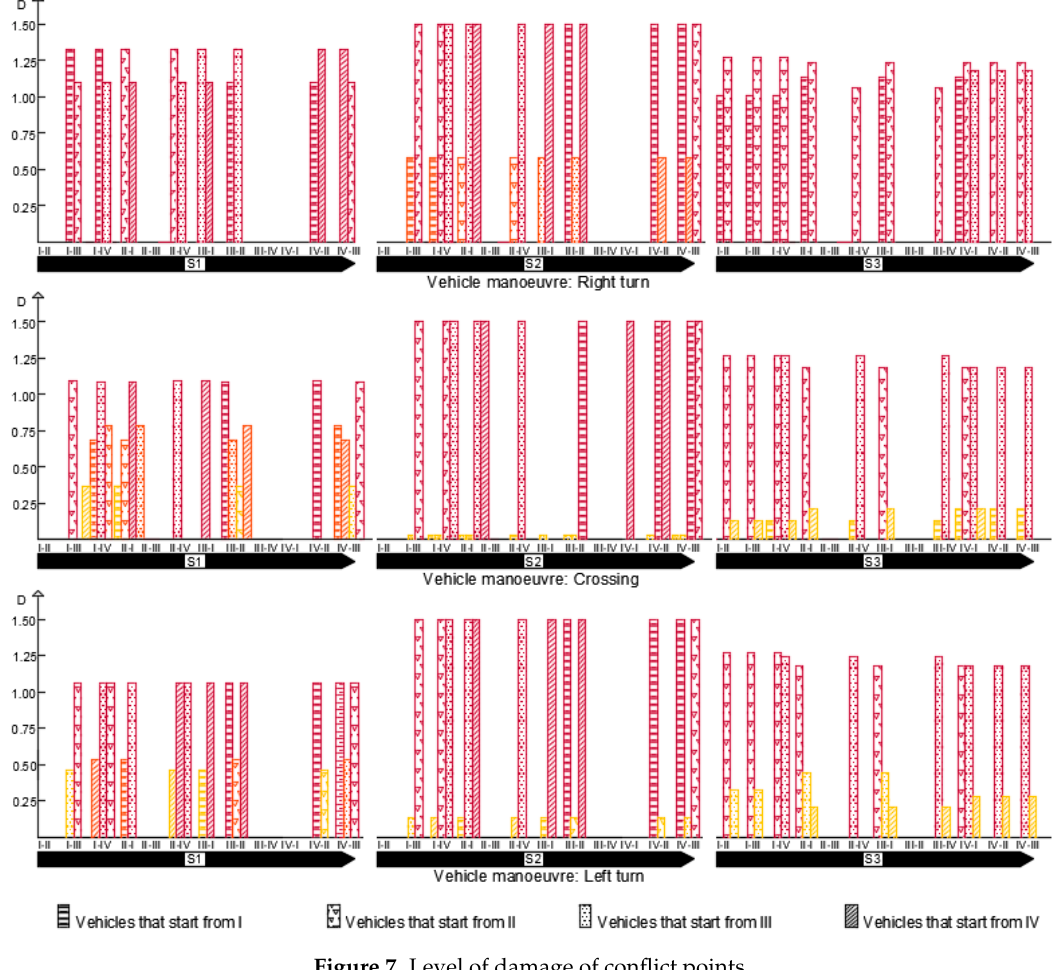
Figure 7. Level of damage of conflict points.